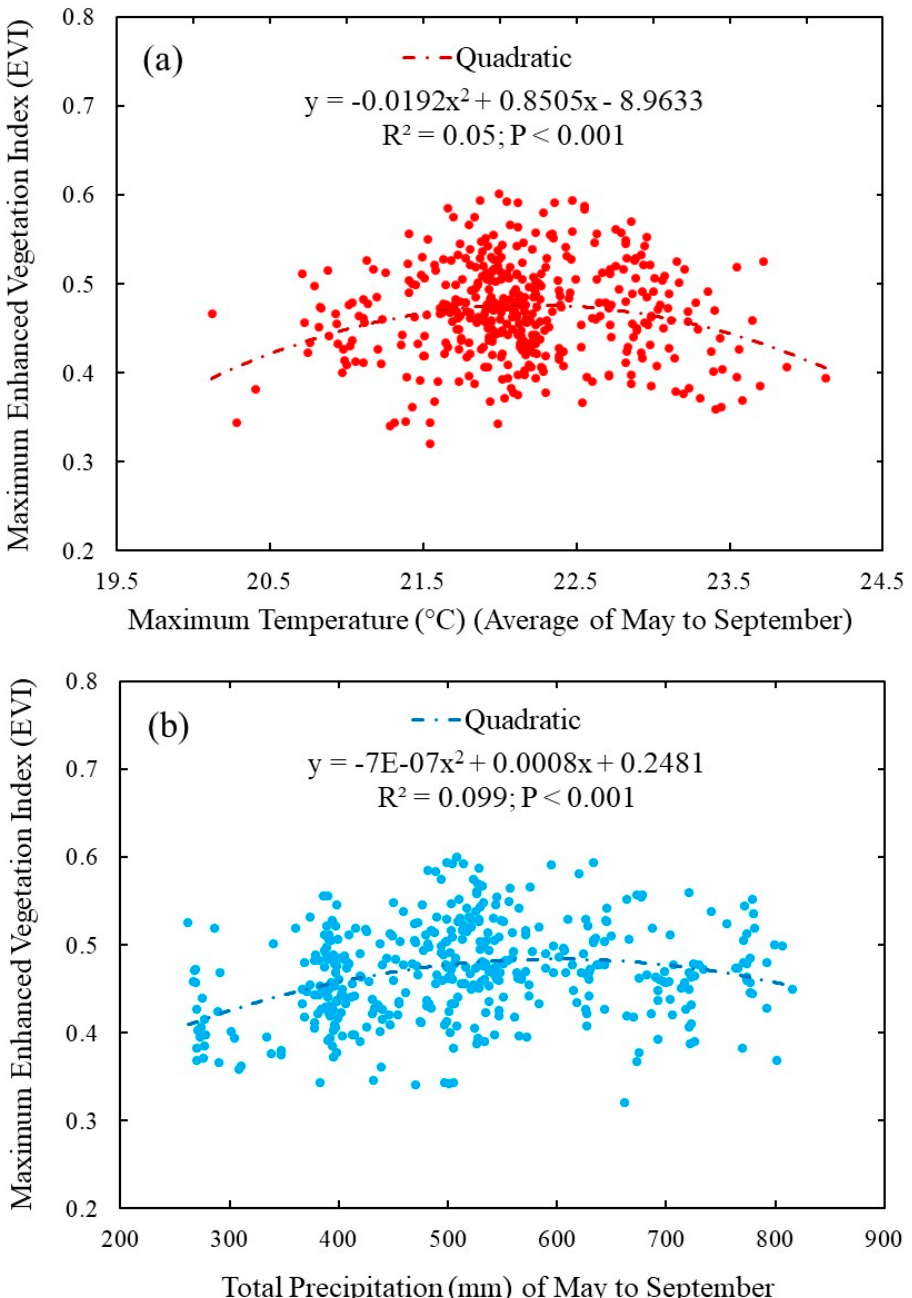
Figure 5. Maximum Enhanced Vegetation Index (EVI max ) of the wild blueberry fields in relation to ( a ) maximum temperature (average of May–September) and ( b ) precipitation (total of May–September), from 2001 to 2017. The observed data points (n = 26 × 17 = 442) are from the 26 wild blueberry fields over 17 years (2001–2017). The dashed lines are quadratic relationships fitted to the data with multiple linear regression ( p < 0.001).